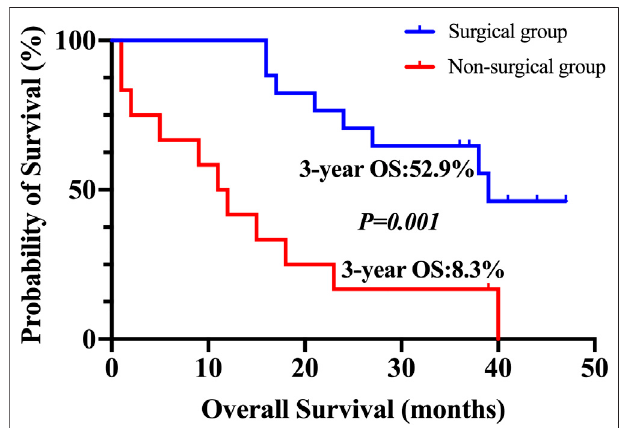
FIGURE 2 | Kaplan – Meier plot for 3-years overall survival. The overall survival for patients who underwent conversion surgery and for those who did